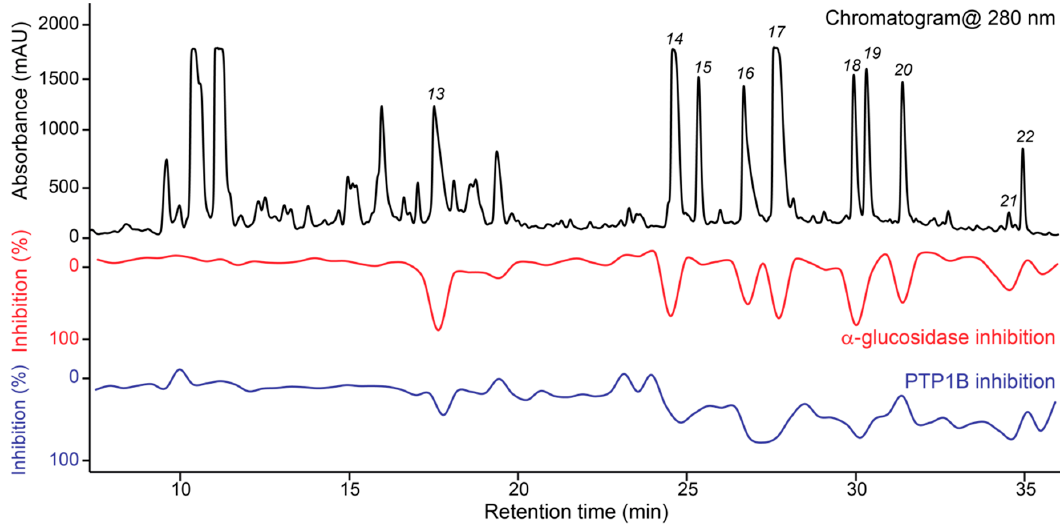
Figure 2. Dual high-resolution PTP1B/ α -glucosidase inhibition profile of Fraction 2 of Gerbera piloselloides shown with the UV chromatogram at 280 nm.